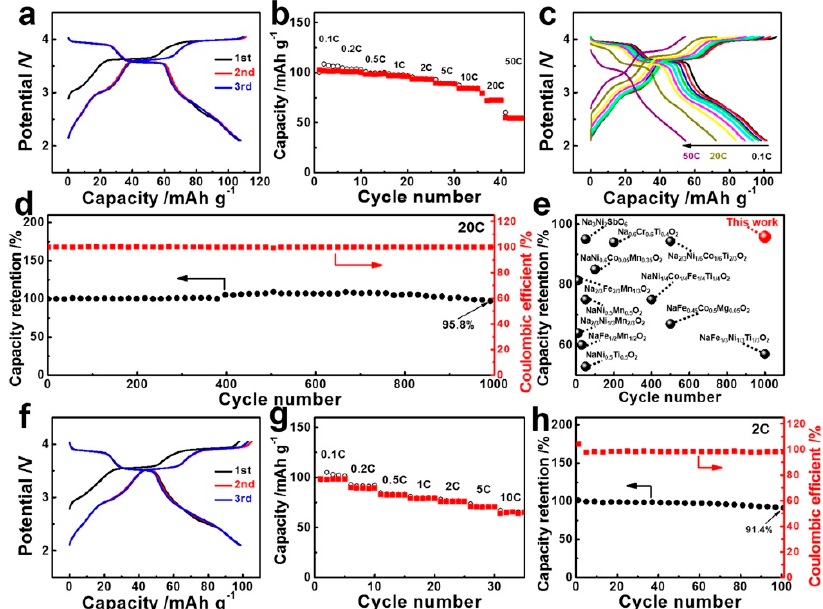
Figure 6. Electrochemical performance of P1-Na 2.3 Cu 1.1 Mn 2 O 7- δ (P1-NCM) in half cells and full cells. ( a ) Typical potential profiles of P1-NCM // Na at 0.1C rate. ( b ) Capability and ( c ) potential profiles of P1-NCM // Na at various current rates. ( d ) Cycling performance and Coulombic e ffi ciency of P1-NCM // Na at 20C rate. ( e ) Summary of cycling stability for conventional layered metal oxide materials. ( f ) Typical potential profiles of P1-NCM // hard carbon at 0.1C rate. ( g ) Capability of P1-NCM // hard carbon at various current rates. ( h ) The cycling performance and Coulombic e ffi ciency of P1-NCM // hard carbon at 2C rate. Reproduced with permission from [151]. Copyright 2018 Elsevier. V-based pyrophosphate compounds look more promising than Fe-based ones, even though their specific capacity is almost the same (80 mA h g − 1 ), because their operating voltage is higher, which